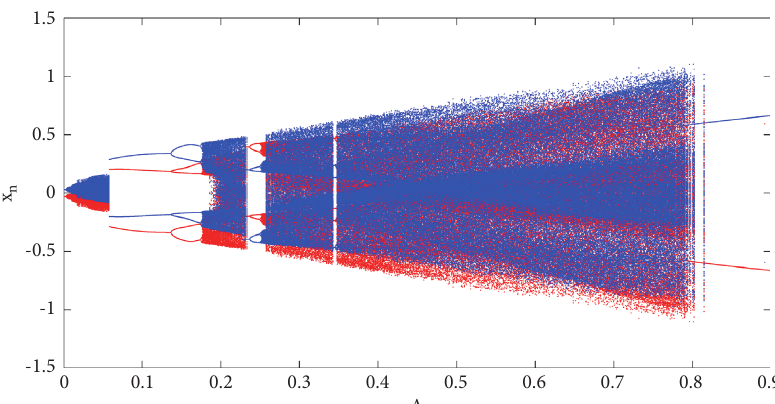
Figure 12: Bifurcation diagram of (14) with respect to parameter A , for B � 0, C � 1, μ � 0 . 2, m � 50, and x